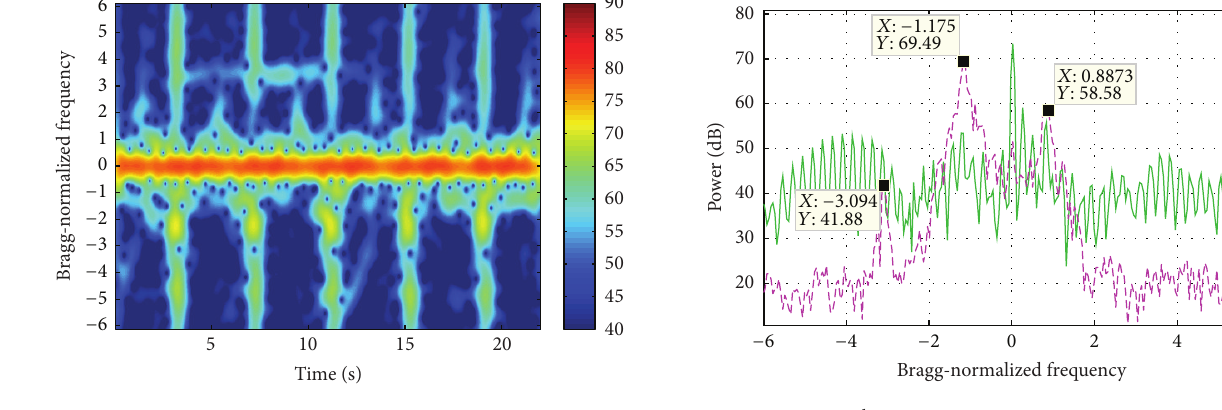
Figure 10: Time-frequency spectrogram of sum signal. noise is weak. The vessel echo is between 3 and 13 s at about 3.5